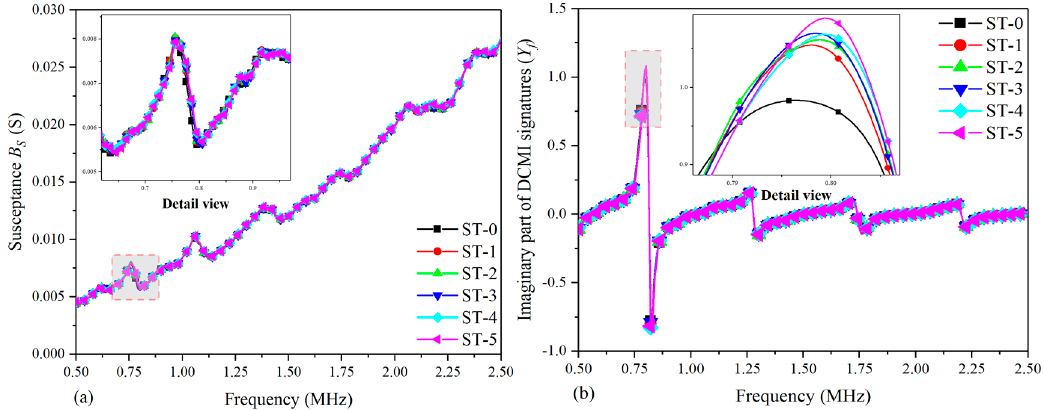
Figure 14. Comparative plots based on imaginary part of signatures for fuselage: ( a ) raw susceptance signatures B s , ( b ) imaginary part of DCMI signatures Y f B